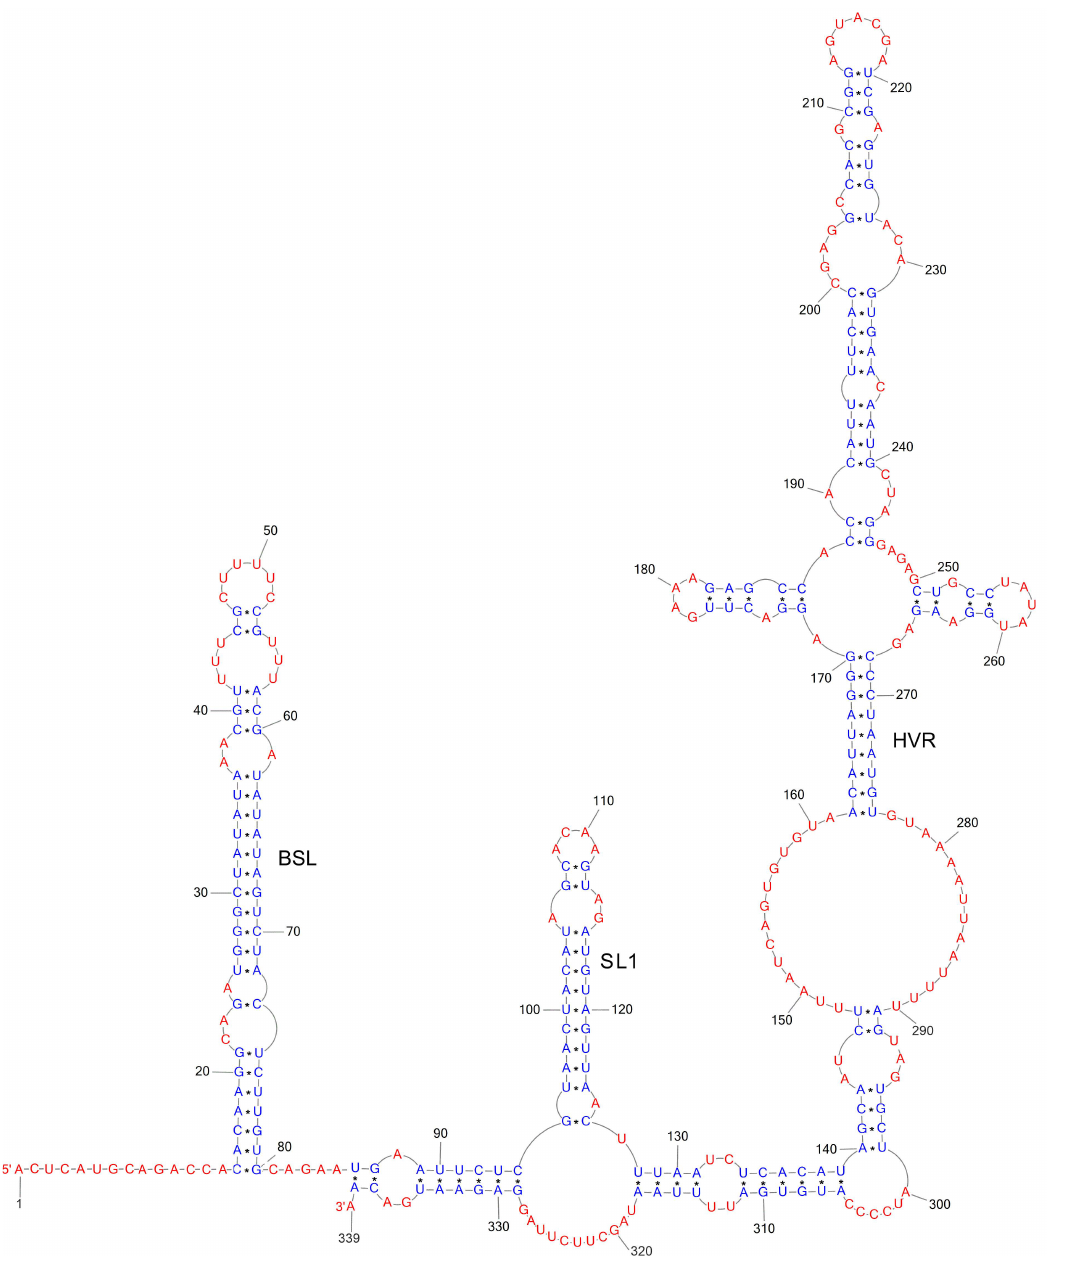
Figure 2. Scheme of SARS-CoV-2 3 (cid:48) UTR. Blue and red letter colors mark paired and unpaired nucleotides,